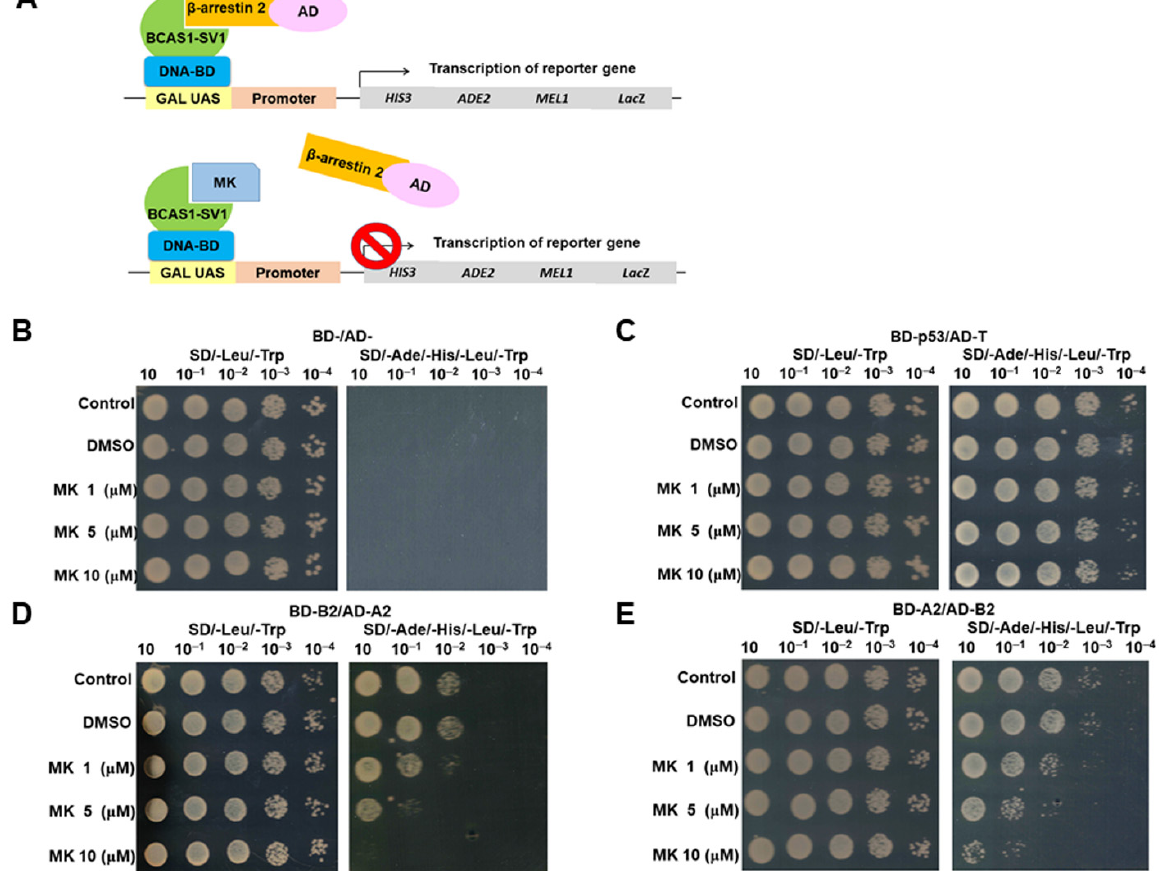
Figure 7. Maackiain (MK) directly inhibits the interaction of BCAS1-SV1 with β -arrestin 2 in a yeast two-hybrid-based growth assay. ( A ) Schematic showing the use of the yeast two-hybrid-based growth assay in identifying inhibitors of protein–protein interactions. ( B-E ) Log-phase cultures of yeast diploid cells containing plasmids encoding either ( B ) Gal4 BD-/Gal4 AD-, ( C ) Gal4 BD- p53/Gal4 AD-T, ( D ) Gal4 BD-B2 (BCAS1-SV1)/Gal4 AD-A2 ( β -arrestin 2), or ( E ) Gal4 BD-A2/Gal4